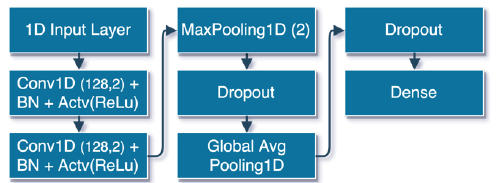
Figure 6. The employed 1D CNN architecture (number of filters and their dimensions are given next to each layer).